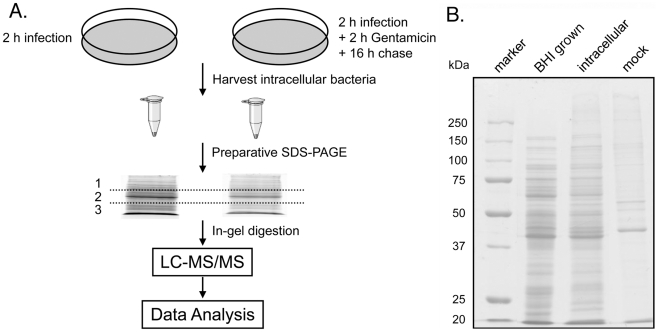
A proteomics approach to profile intracellular C. jejuni.
A A schematic diagram of the experimental approach used in this study. B SDS-PAGE analysis of extracted proteins from C. jejuni samples. Proteins obtained from intracellular bacteria isolated following the protocol described above (intracellular), from equal number of bacteria obtained after growth in Brain Heart Infusion broth (BHI grown) or from uninfected cells subjected to the same protocol (mock), were separated by SDS-PAGE and stained with Coomassie brilliant blue.